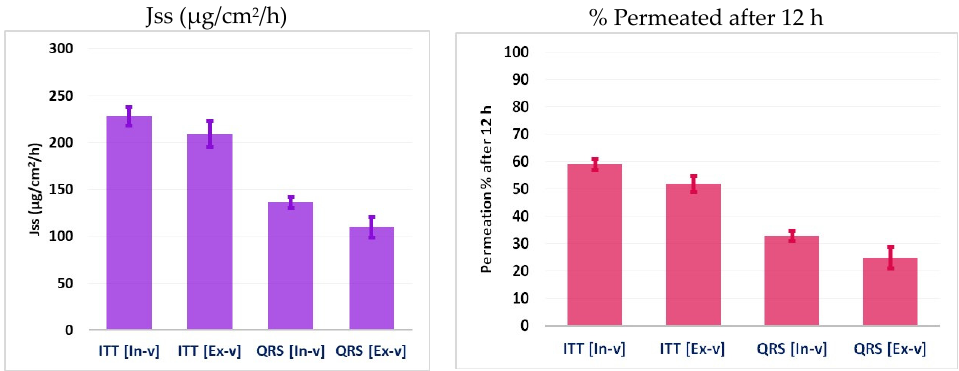
Figure 6. In Vitro [In-v] and ex vivo [Ex-v] permeation and Jss results of the optimized formulation loaded with ITT-QRS SNEDDS. Data presented as the mean ± standard deviation. ( n = 3). The level of significance was considered at p < 0.05.